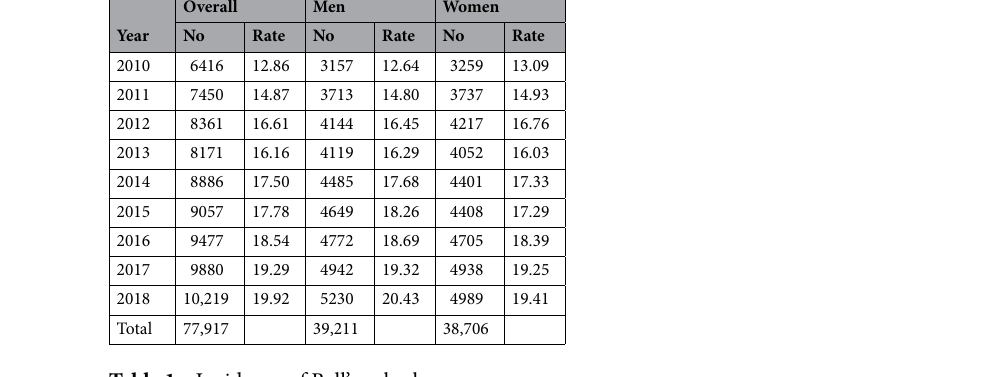
Table 1. Incidence of Bell’s palsy by